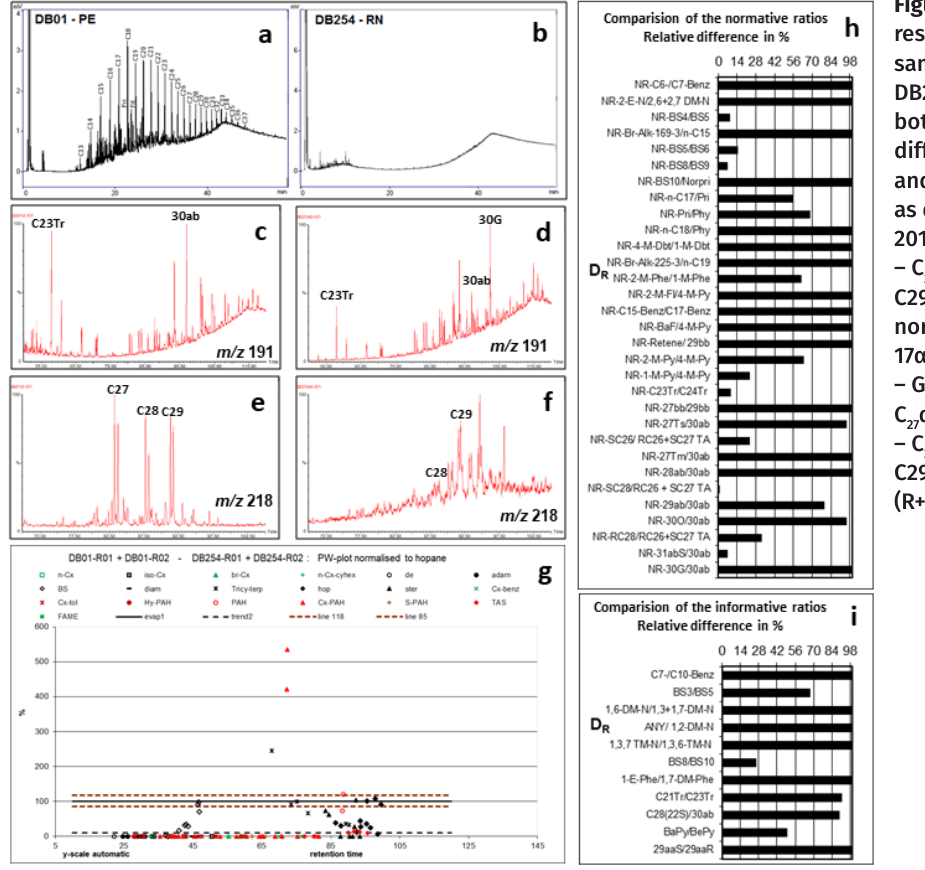
Figure 11. Combined results between samples DB01 and DB254, indicating that both samples are from different sources (DRs and compound